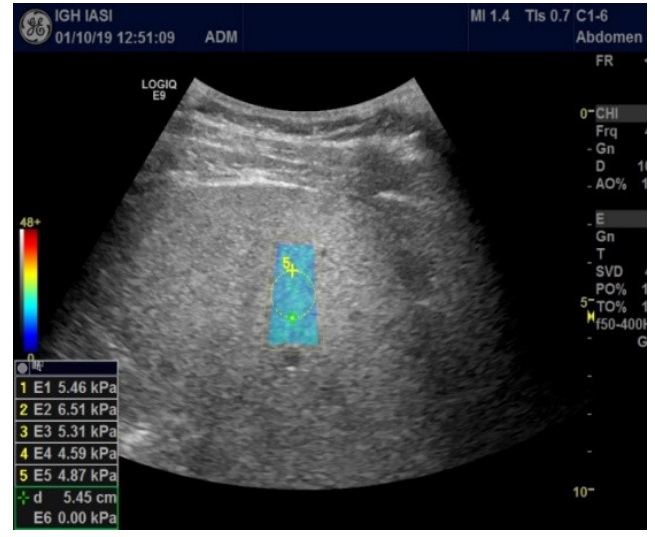
Figure 1. 2D-SWE.GE elastography (measurement panel, color map).